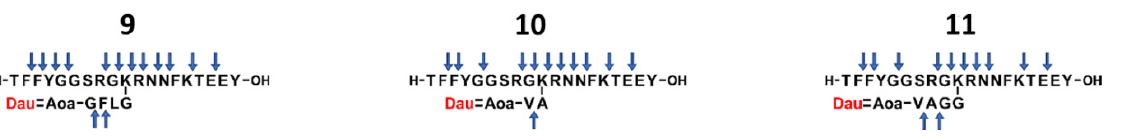
Figure 5. The identified cleavage sites (indicated by blue arrows) of the enzyme-labile spacer containing Angiopep-2 – daunomycin conjugates in lysosomal homogenate. As expected, the VA spacer alone (compound 10 ) inhibited the enzymatic cleavage because of the isopeptide bond between the alanine and the lysine side chain, and the